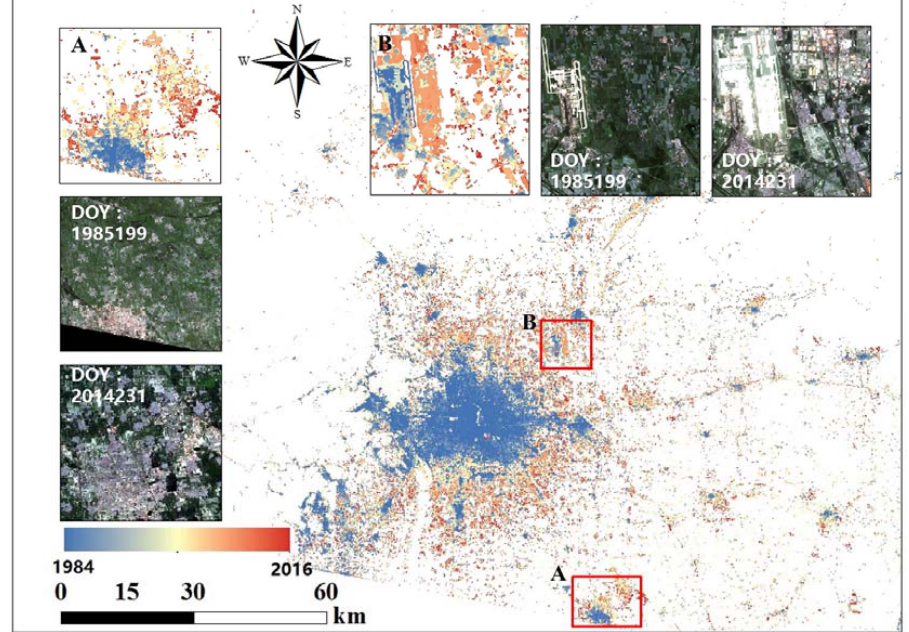
Figure 6. Urban expansion in Beijing during 1984–2016. The map shows the current distribution of urban area (color shading) with sites that were built earlier taking lower values (blue) and sits that were built more recently taking higher values (red). Two magnified insets show the changes: ( A ) zoomed-in view of Langfang region, and ( B ) zoomed-in view of Beijing Capital airport region. The corresponding Thematic Mapper (TM) images of Langfang and Beijing Capital airport are also shown using RGB-5, 4, 3 representations of images collected on 19 July 1985 and 20 August 2014, respectively.